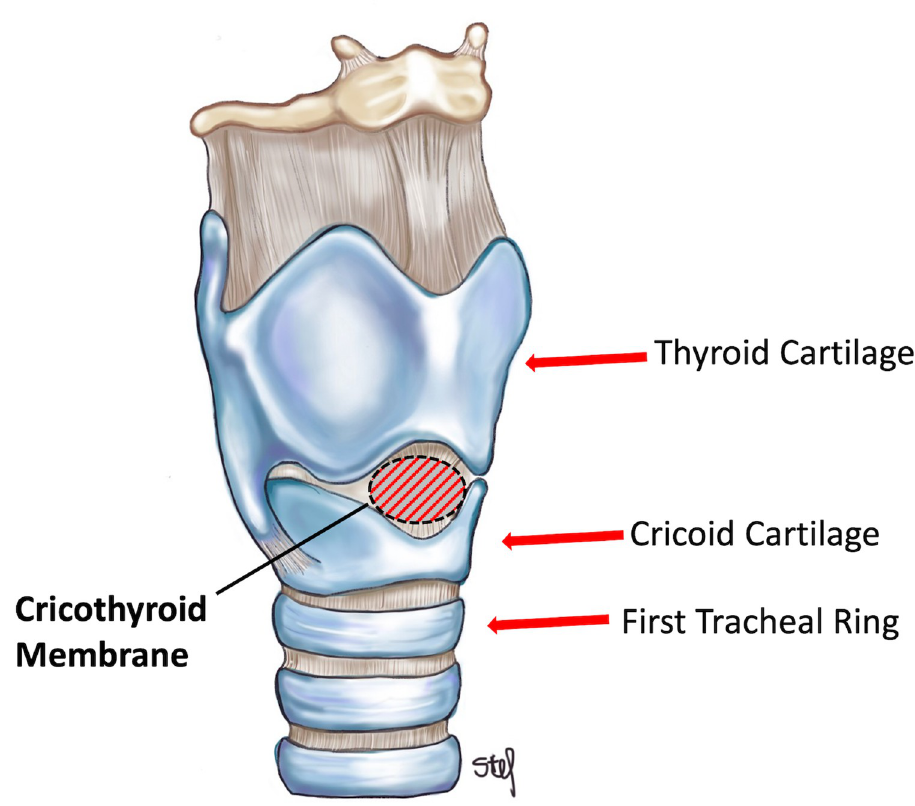
Fig 1. Overview of laryngeal and upper tracheal